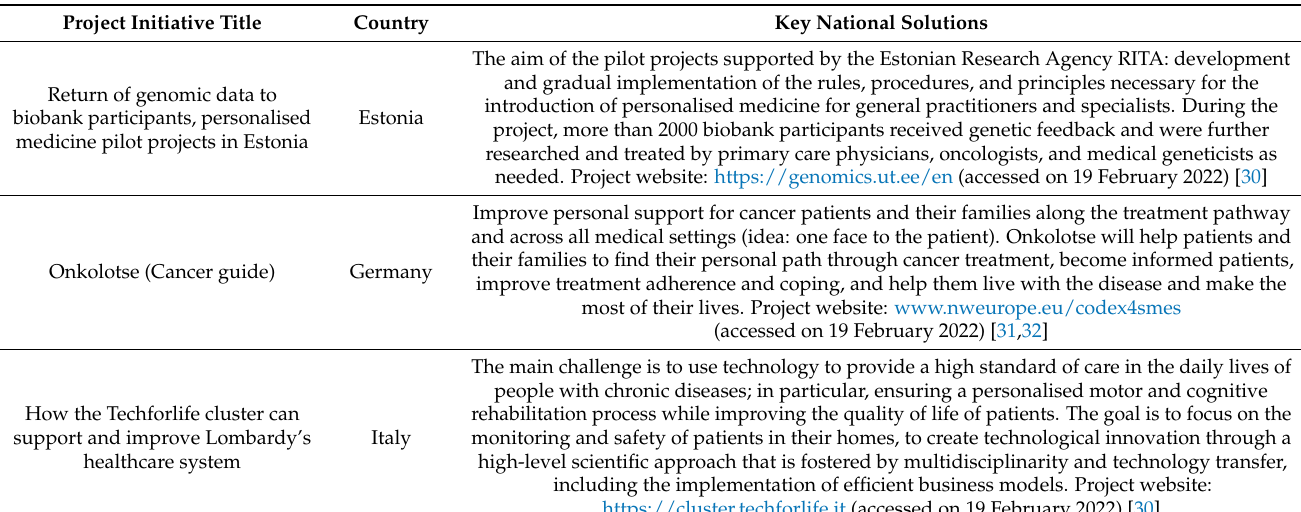
Table 4. Existing solutions in the field of personalised medicine—a synthesis based on the Best Practices Booklet within the Regions4PerMed project